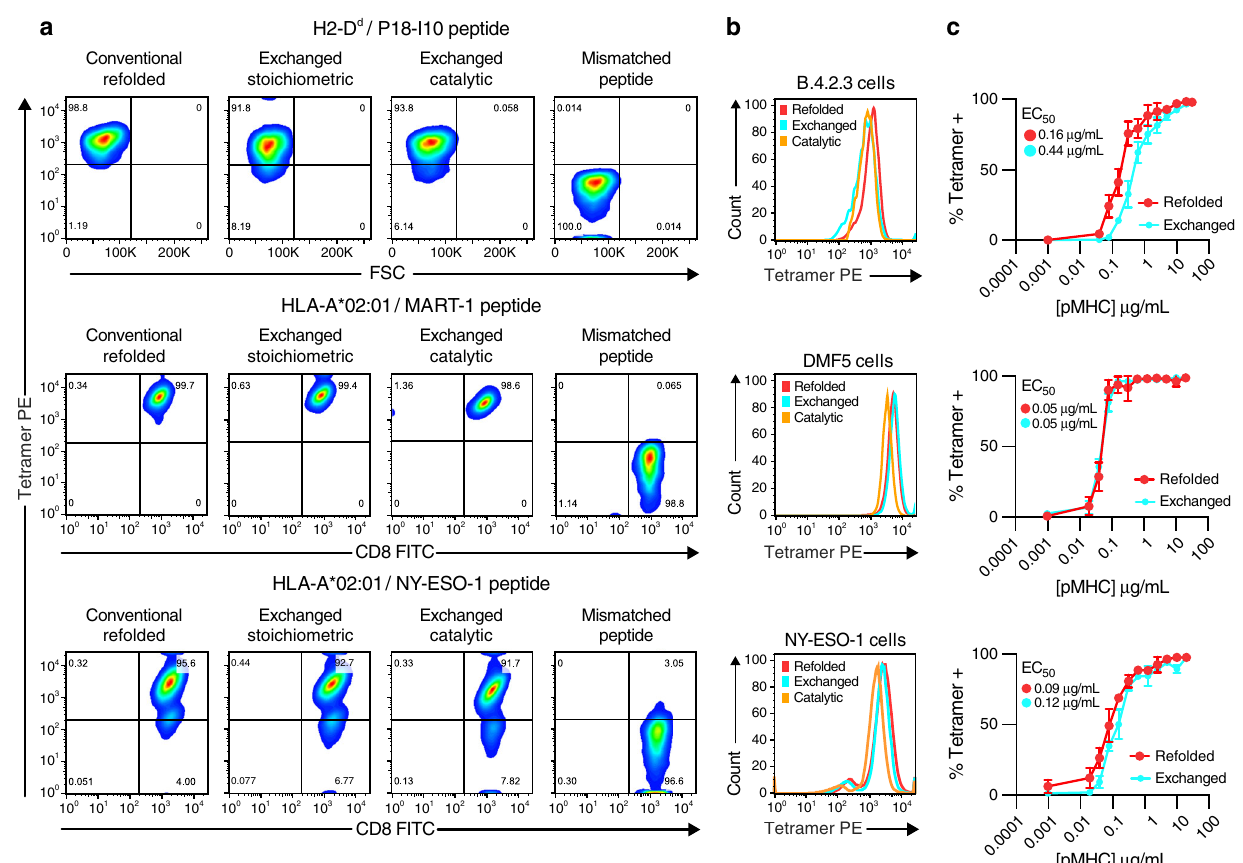
Fig. 5 Flow cytometry using TAPBPR-exchanged pMHC-I tetramers. a Representative fl ow cytometric analysis of top row; murine cells expressing the B4.3.2 TCR, middle row; DMF5 human T cells expressing the MART-1 TCR, bottom row; NY-ESO-1 human T cells expressing the NY-ESO-1 TCR. Columns depict staining with a fi xed excess (1 µ g/mL) of P18-I10/H2-D d , MART-1/HLA-A*02:01 and NY-ESO-1/HLA-A*02:01 tetramers prepared either by conventional refolding, exchange of peptide on stoichiometric MHC-I/TAPBPR complexes, TAPBPR-mediated peptide exchange using a catalytic (1:100) TAPBPR to MHC-I molar ratio or by stoichiometric exchange of a mismatched peptide, not recognized by the respective TCRs. b Histogram plots of tetramer staining. c Tetramer titration of P18-I10/H-2D d (top), MART-1/HLA-A*02:01(middle) and NY-ESO-1/HLA-A*02:01 (bottom), prepared by exchange of each peptide on the corresponding stoichiometric MHC-I/TAPBPR complexes. Percentage of cells staining positive with tetramer over a serial two-fold dilution series were plotted and EC 50 values calculated by curve fi tting to a sigmoidal line (with R 2 values in the 0.97 – 0.99 range), using Graph Pad Prism version 8 (GraphPad Software, La Jolla California USA). Data shown are representative of triplicate assays ( n = 3) and error-bars are standard deviations from the mean. Gating strategies used for sorting tetramer-positive cells are outlined in Supplementary Fig. 4. Source data are provided as a Source Data fi